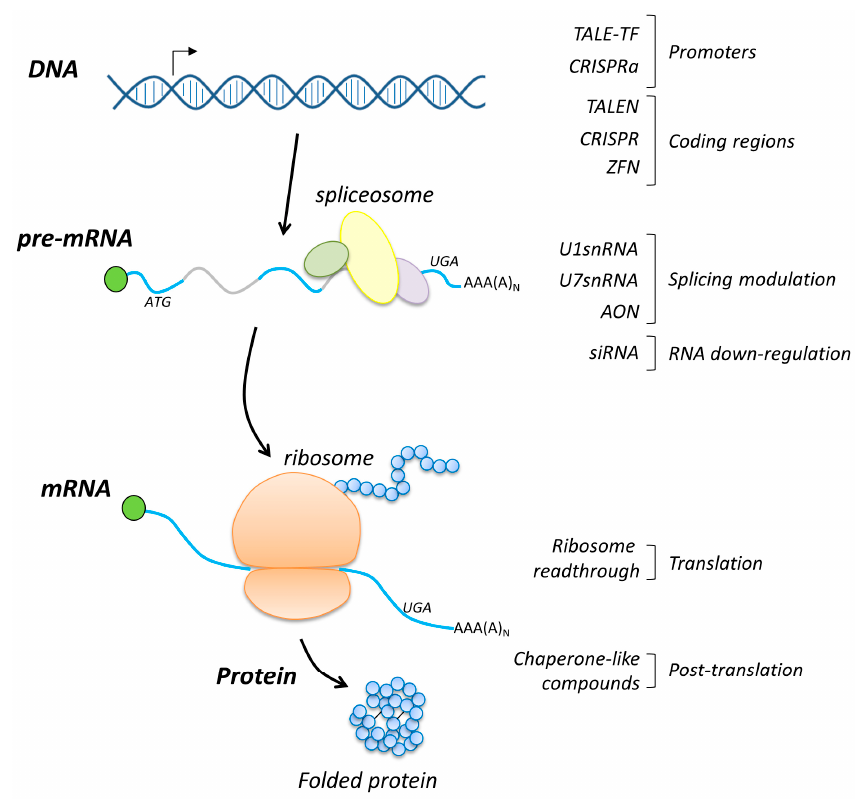
Figure 2. Overview of the interventions at the DNA, RNA and protein levels. Schematic representation of the DNA–RNA–protein flow ( left ) as well as of the corresponding molecular approaches with the indicated level at which each strategy works ( right ). In the pre-mRNA scheme, exons and introns are indicated in cyan and grey, respectively.